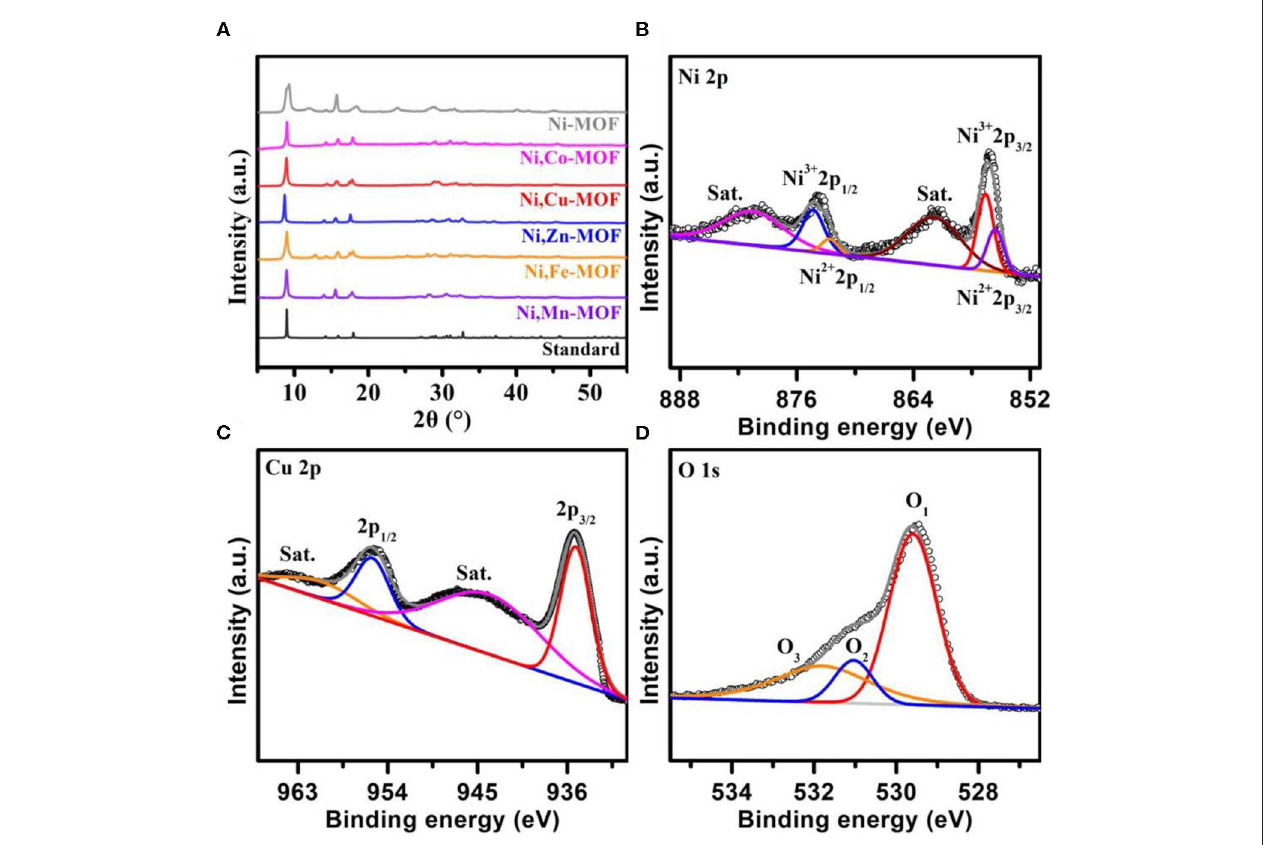
FIGURE 3 | (A) The XRD patterns of Ni-MOF, Ni,Co-MOF, Ni,Cu-MOF, Ni,Zn-MOF, Ni,Fe-MOF, Ni,Mn-MOF and the standard pattern, respectively. (B–D) High-resolution XPS spectra of Ni 2p, Cu 2p, and O 1s.